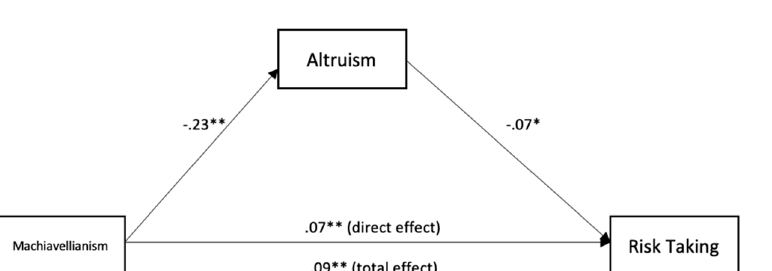
Figure 1. Mediation analysis for the relationship between Machiavellianism, altruism, and risk-taking. * p < 0.05; ** p < 0.01.